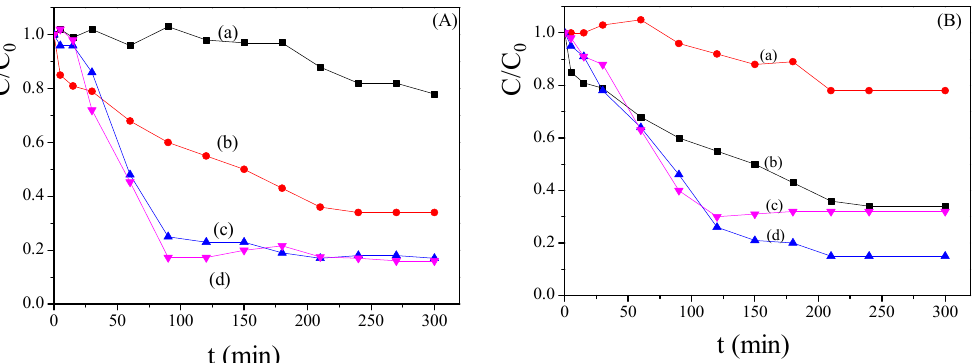
Figure 7. Relative PY concentration as a function of time for Mn-containing ( A ) and Cu-containing ( B ) catalysts: (a) M 1 -NaY; (b) Fe-NaY; (c) FeM 2 -NaY and (d) M 1 Fe-NaY: Reaction conditions: 50 mg of catalyst, V PY = 250 mL, C 0 = 30 ppm, initial pH = 3.00, C H2O2 = 12 mM, T R = 40 °C.